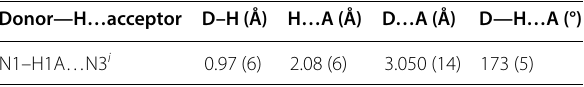
Table 4 Hydrogen bonds parameters (Å) of OCT